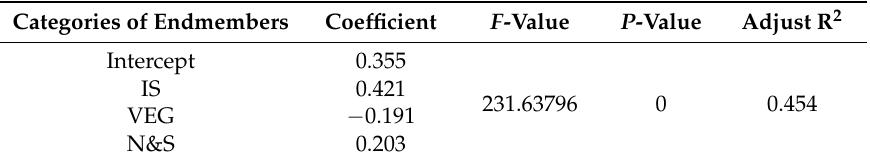
Table 5. Results of the fitting Table 4 . Results of the fitting analysis.